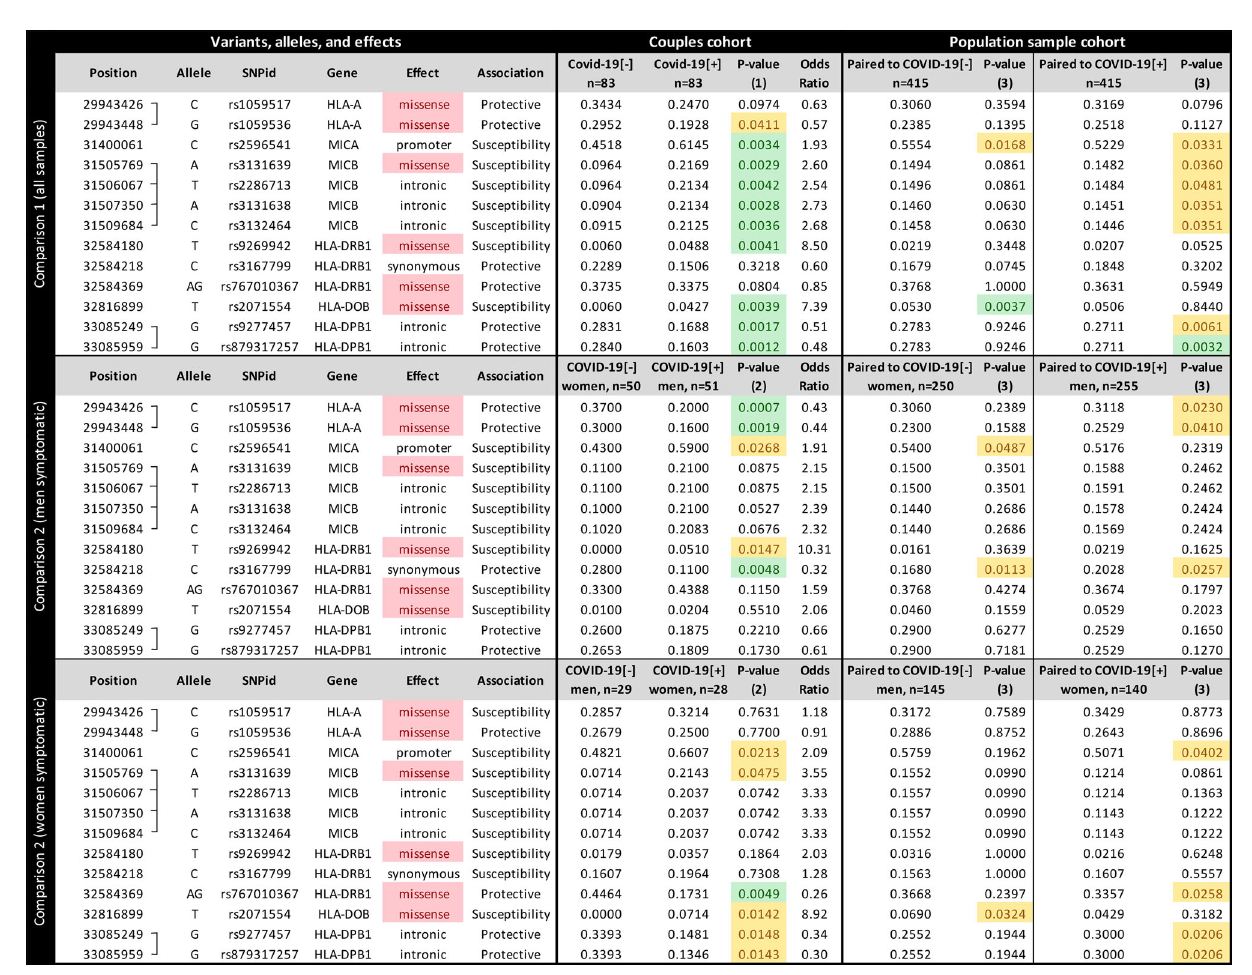
FIGURE 2 | The frequency of each candidate variant at the Major Histocompatibility Complex (MHC) associated with susceptibility to SARS-CoV-2 symptomatic infection or with asymptomatic and seronegative after exposure. COVID-19[+]: Patients with symptomatic COVID-19. COVID-19[-]: Individuals sharing the same bed with symptomatic patients (exposed individuals) and are asymptomatic and seronegative. P-value (1): Logistic regression comparing all COVID-19[+] and all COVID- 19[-] individuals, controlling for sex, age, and genetic ancestry; P-value (2): Logistic regression comparing COVID-19[+] and COVID-19[-] individuals, controlling for age, and genetic ancestry; P-value (3): Fisher exact test, comparing COVID-19[+] or COVID-19[-] individuals with a population sample paired by gender and genetic ancestry. In green, P-values < 0.005; In yellow, P-value between 0.005 and